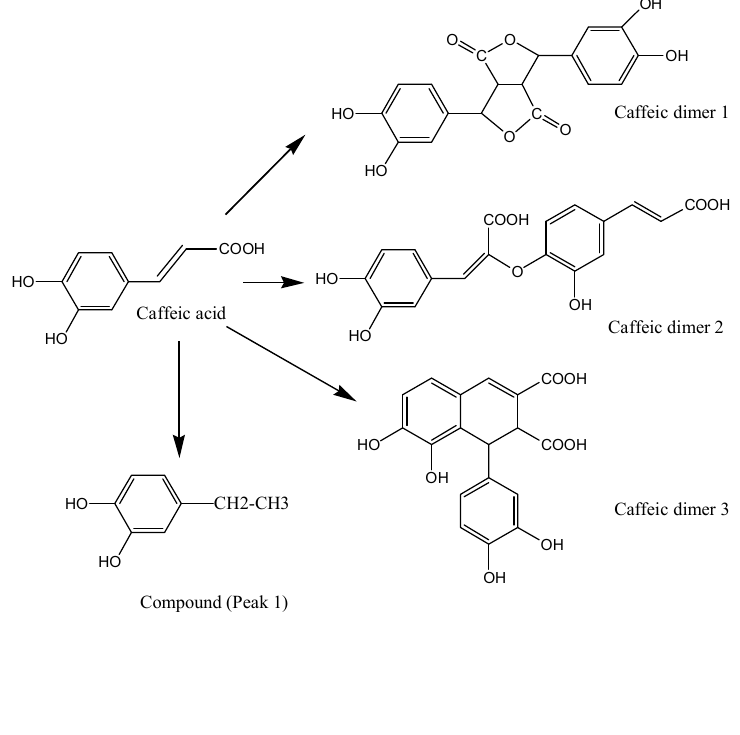
Figure 9. The proposed degradation mechanism of caffeic acid under ultrasound treatment